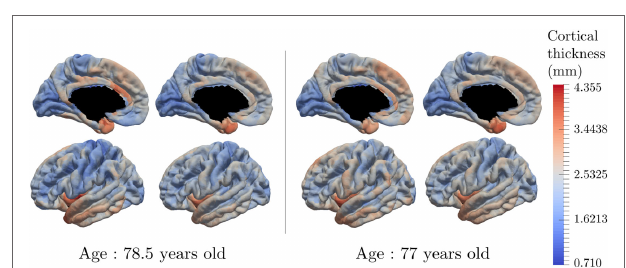
FIGURE 9 | Real data and data reconstruction for subjects with a small space shift (right) and large space shift (left). The model is able to reconstruct the observed data, with a smoothing component, for subjects that present different